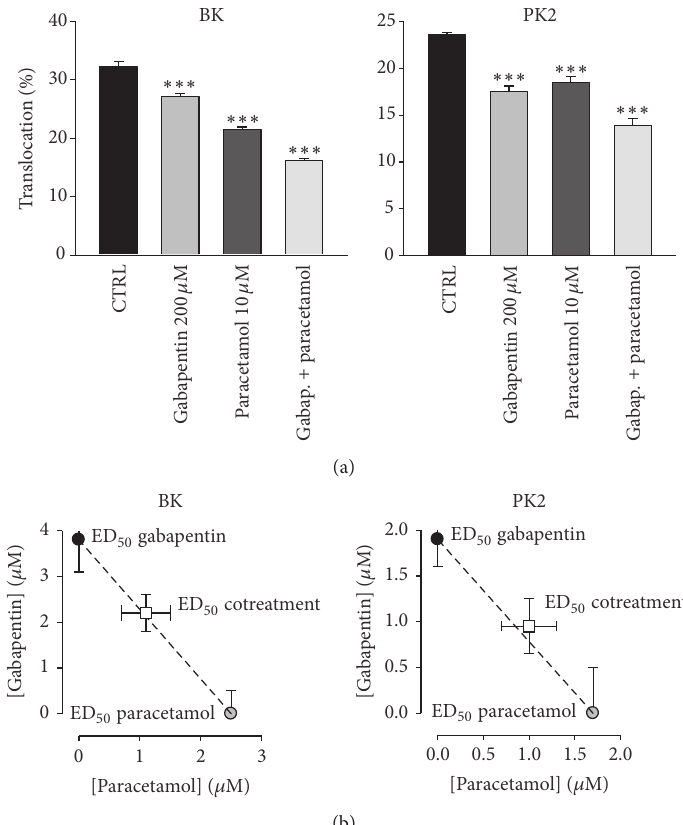
Figure 3: PKC translocation suppression by gabapentin and by paracetamol is additive. (a) Experiments on bradykinin- (BK-) induced and PK2-induced PKC 𝜀 translocation. Gabapentin effect on the latter was almost double compared to the former, with about 14.2% suppression on bradykinin-induced translocation and 25.4% suppression on PK2-induced translocation, compared to control (CTRL). Paracetamol-induced suppression was 33.4% (BK) and 21.6% (PK2). Combined drug suppression was, respectively, 49.8% and 41.9%, consistent with an additive effect of these drugs. (b) Isobolograms for the effects of gabapentin and paracetamol, alone or in combination, in BK- and PK2-induced PKC 𝜀 translocation. White square symbols correspond to the experimental cotreatment ED 50 with 95% confidence limits. Circle symbols correspond to ED 50 for gabapentin and paracetamol alone. Notes: values are means ± SEM of data from 5 separate cultures. ∗∗∗ 𝑃 < 0.001 versus control and versus other treatments in all combinations (ANOVA followed by Bonferroni’s 𝑡 -test).